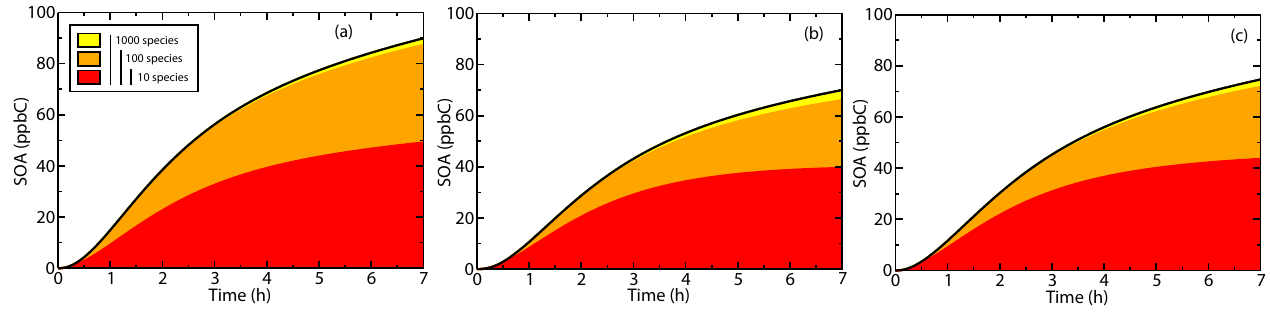
Fig. 6. Contribution of the top 10 (red), top 100 (red+orange) and top 1000 (red+orange+yellow) organic species to the total simulated SOA mass for the low-NO x experiment obtained with JR/ MY (a) , SIM (b) and NAN/NAN (c) .